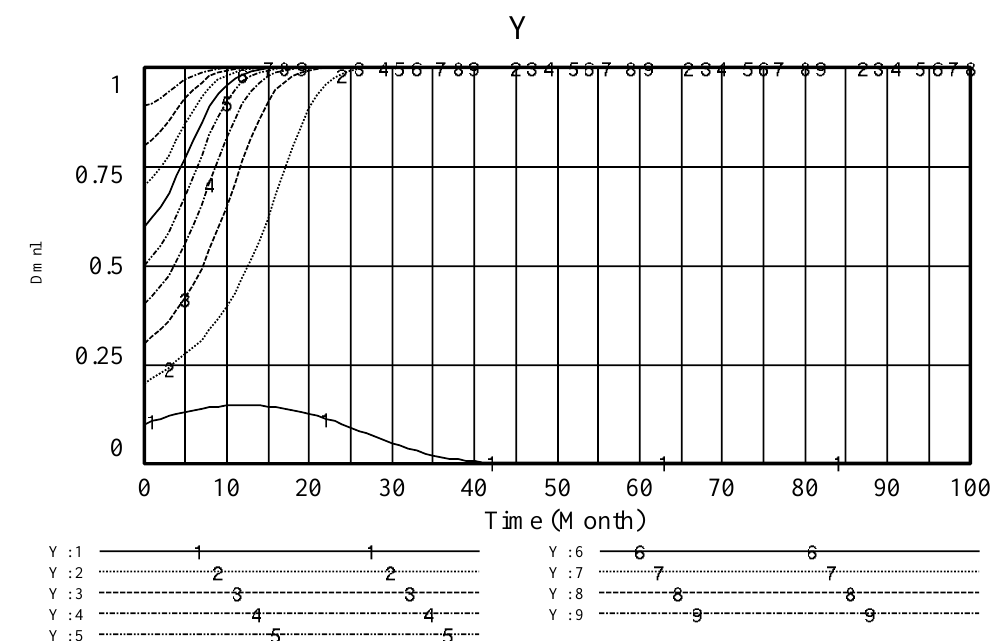
Figure 6. Simulation result of y when initial value of x is 0.6.